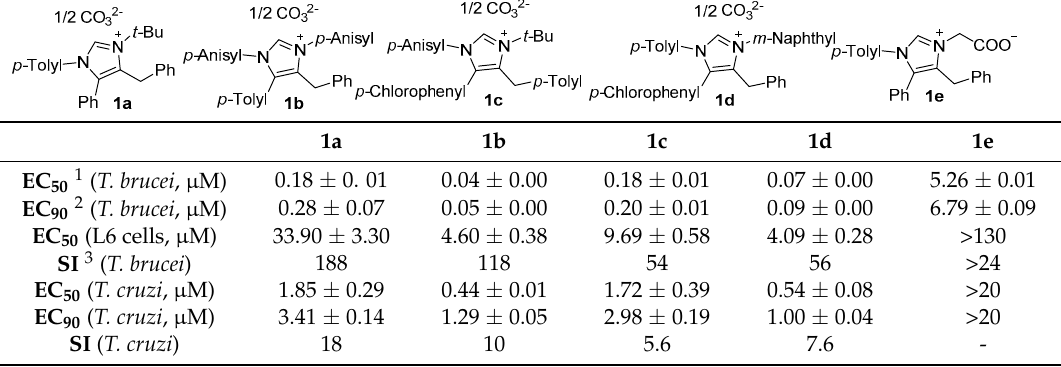
Table 2. Biological activity of compounds 1 vs. bloodstream form T. brucei and T. cruzi epimastigotes.